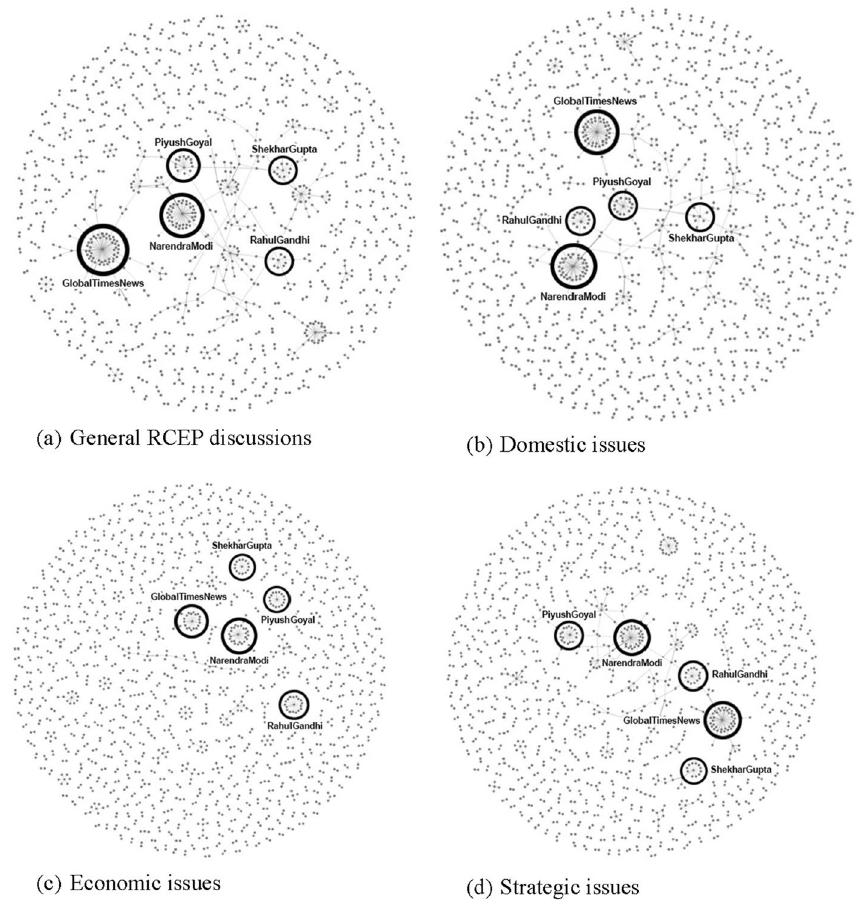
Fig. 15 Network analysis of RCEP